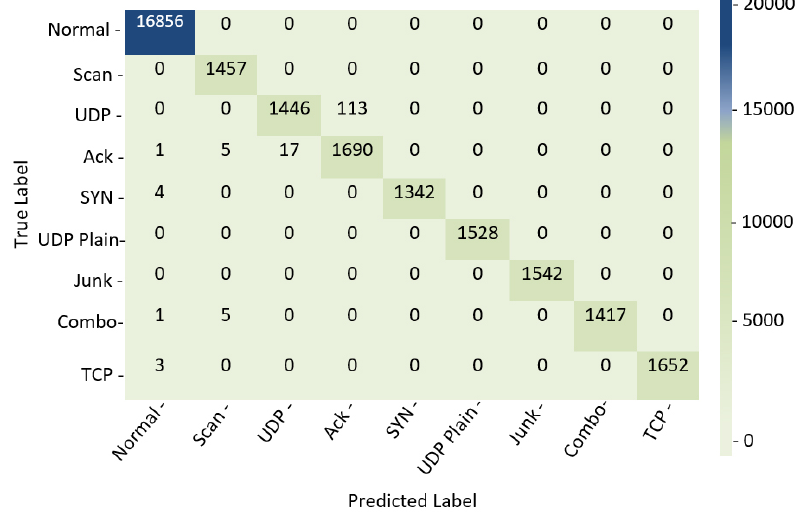
Figure 7. Confusion matrix